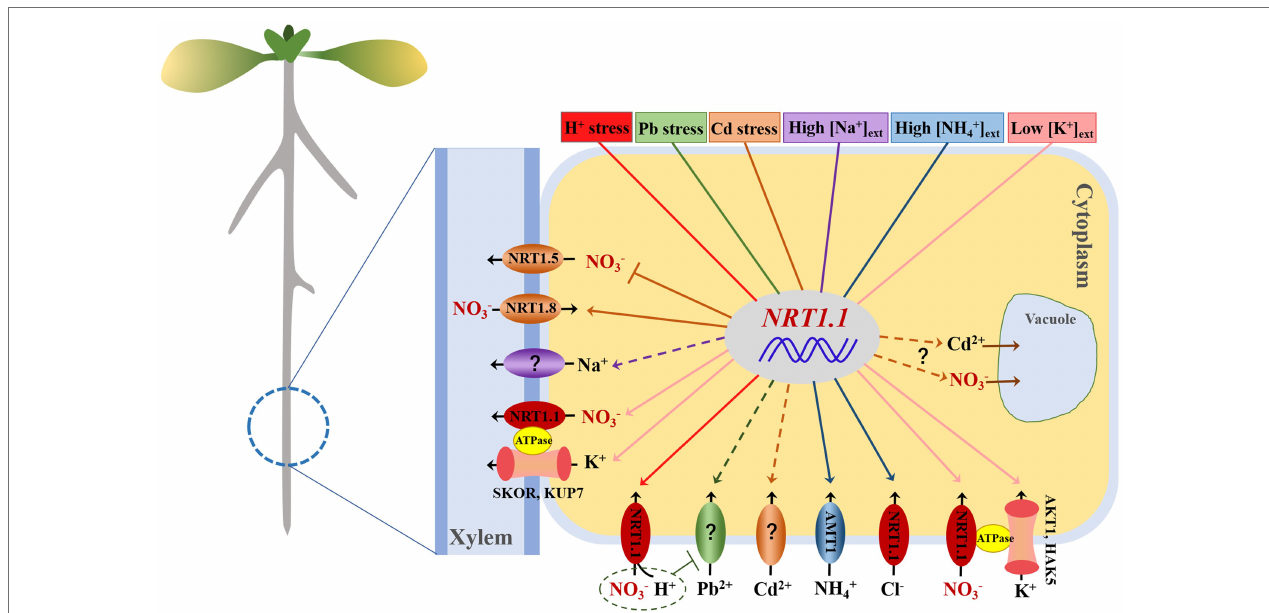
FIGURE 2 | Schematic illustration of NRT1.1 nitrate transport in response to different stresses by mediating several transporters/channels. Proton toxicity (in red), lead stress (green), cadmium stress (orange), high external salt (purple), high external ammonium (blue), and low external potassium (pink). Arrows in solid lines and broken lines denote the demonstrated positive regulation and hypothetical regulation of transporters/channels by NRT1.1, respectively. Blunt arrows indicate negative regulation of targets by